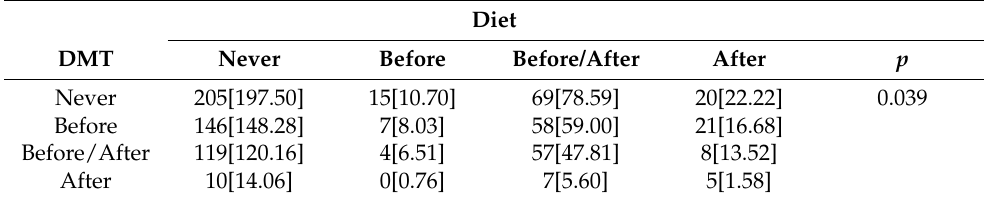
Table 9. Observed [Expected]. Frequencies of MS diet and disease-modifying drug